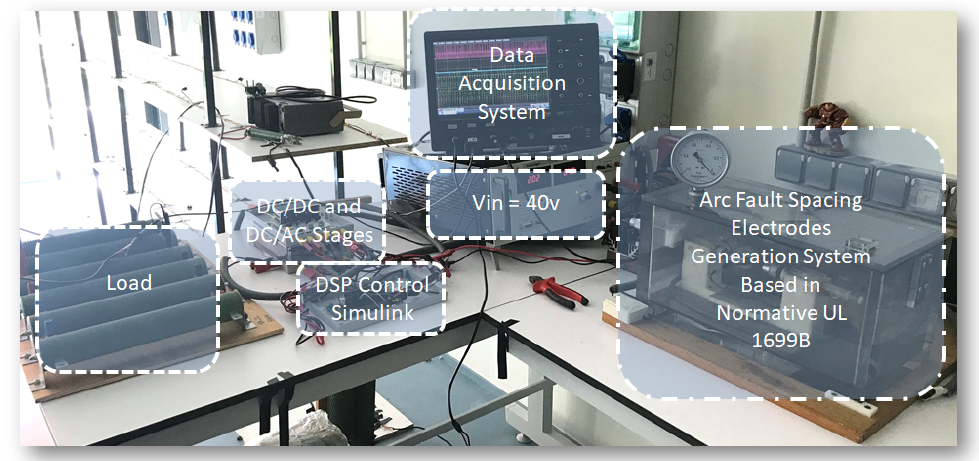
Figure 5. Experimental test